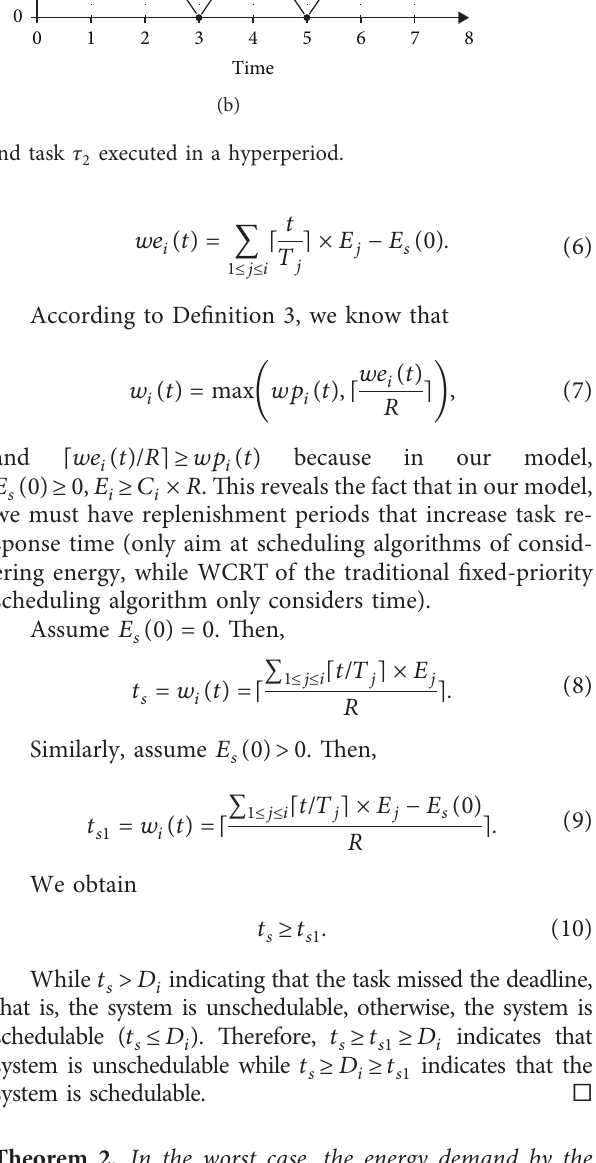
and task τ executed in a 1 2